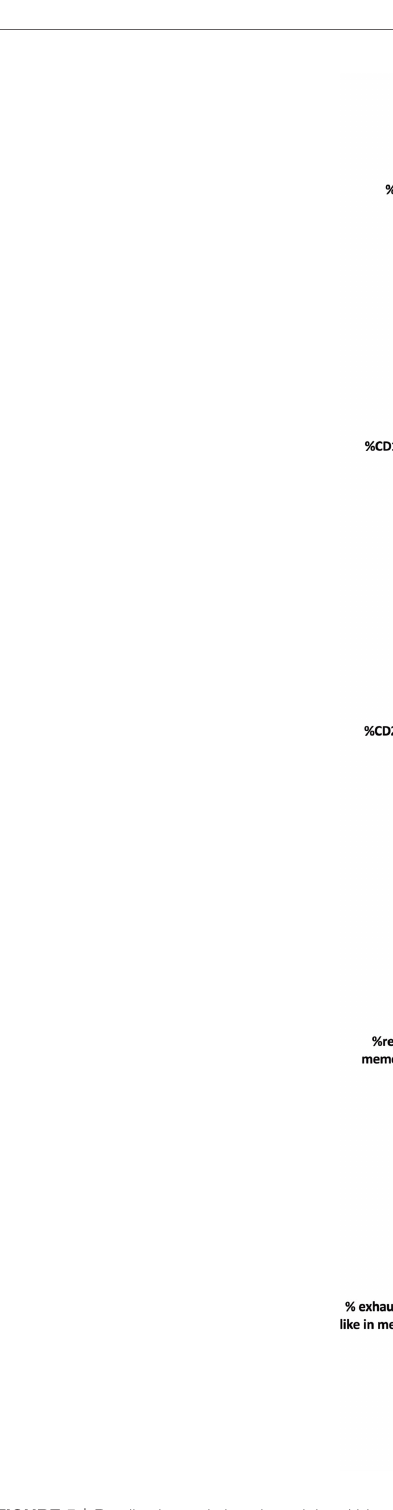
FIGURE 5 | B cell subpopulations in peripheral blood. Frequencies of (A, B) CD19 + CD20 + B cells, (C, D) CD10 + CD19 + CD20 + , (E, F) CD27 + CD19 + CD20 + , (G, H) resting memory B cells and (I, J) exhausted tissue-like memory B cells measured in peripheral blood of (A, C, E, G, I) HD- and (B, D, F, H, J) non-HD patients without SARS-CoV-2 infection (orange circles, HD: n = 10; light blue circles, non-HD: 6), with mild/asymptomatic (light red circles, HD: n = 18; mid blue circles, non-HD: n = 9), moderate (red circles, HD: n = 11; blue circles, non-HD: n = 11) and severe COVID-19 disease (black circles, HD: n = 2; dark blue circles, non-HD: n = 13). Severe and moderate COVID-19 HD patients were analyzed as one group. Data are shown as individual values as well as